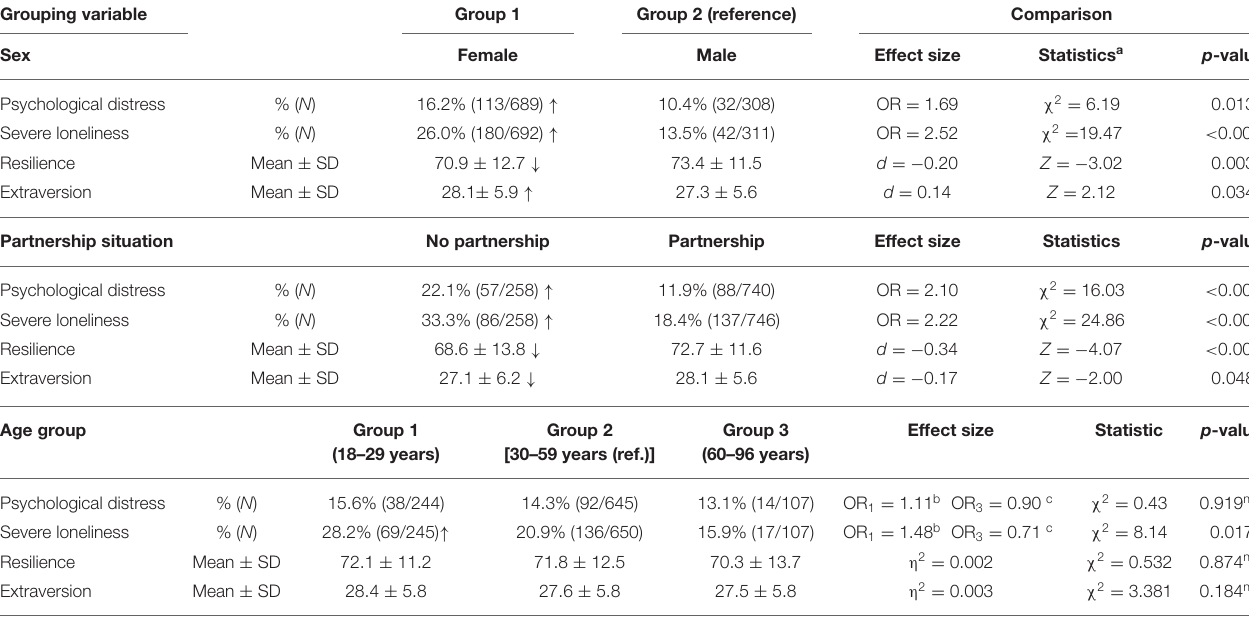
TABLE 2 | Differences in psychological distress, loneliness, resilience, and extraversion between subgroups (sex, partnership situation, and age group).